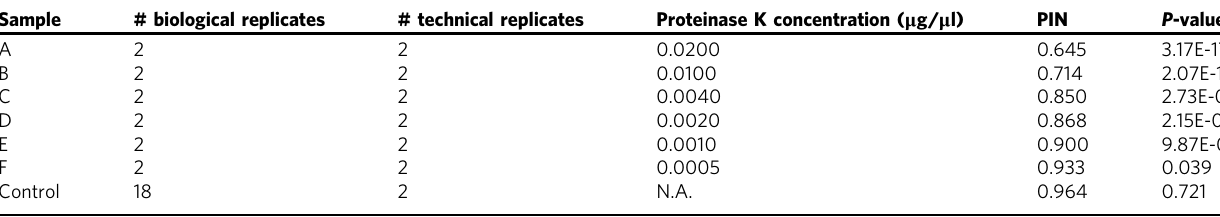
P -values were obtained from the PIN algorithm by probability distribution fi tting